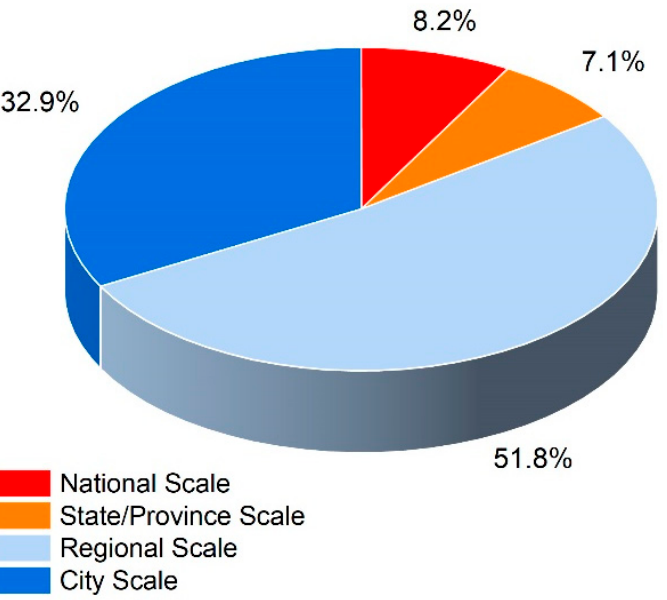
Figure 9. Research scale in the selected articles. The numbers in the figure indicate the percentage of different research scales.